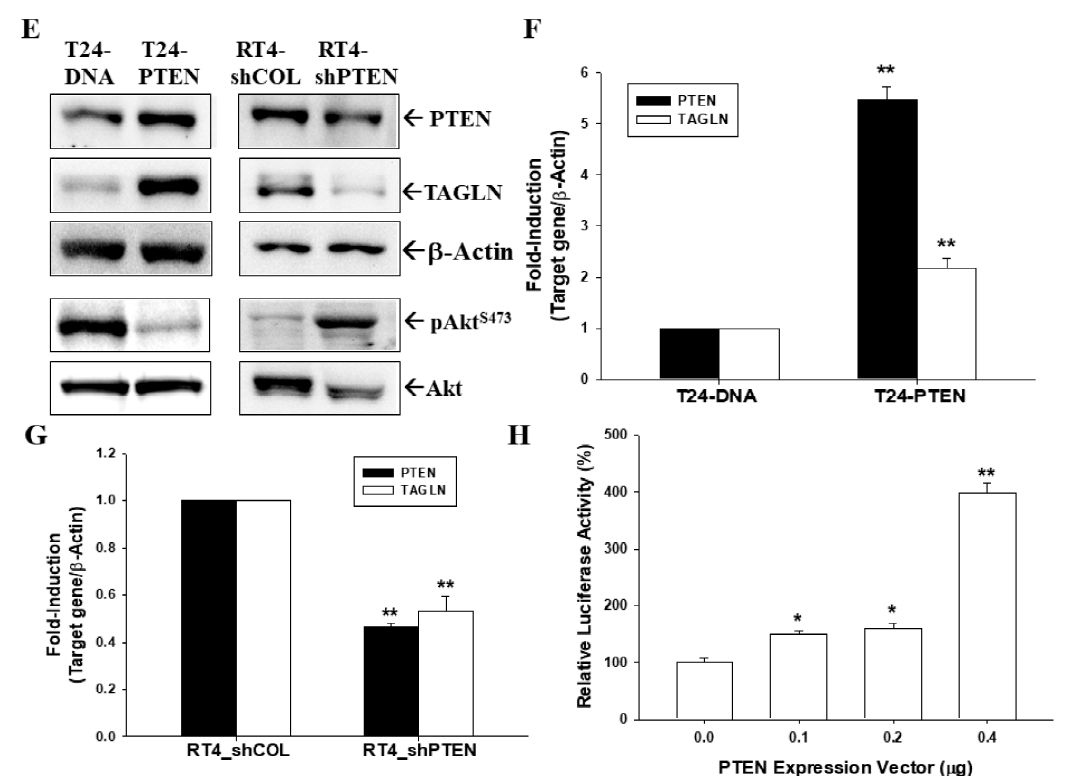
Figure 6. Modulation of p53 and PTEN on TAGLN expression in bladder carcinoma cells. The mock-transfected HT1376 (HT-DNA) and p53-overexpressed HT1376 (HT-p53) cells were lysed, and then TAGLN, p53, and β -actin were determined by immunoblotting ( A ) and RT-qPCR ( B ) assays (± SE; n = 3). The mock-knockdown RT4 (RT4_shCOL) and p53-knockdown RT4 (RT4_shp53) cells were treated with camptothecin (1 μ M) for 16 h. The cells were lysed, and then TAGLN, p53, and β -actin were determined by immunoblotting ( C ). ( D ) The reporter activity of TAGLN reporter vector cotrasnfected with various dosages of p53, as indicated in HT1376 cells. Data are expressed as the mean percentages ± SEs ( n = 6) of luciferase activity relative to the mock-transfected group. The mock-transfected T24 (T24-DNA), PTEN-overexpressed T24 (T24-PTEN), mock-knockdown RT4 (RT4_shCOL), and PTEN-knockdown RT4 (RT4_shpPTEN) cells were lysed, and then TAGLN, PTEN, Akt, pAkt S473 , and β -actin were determined by immunoblotting ( E ). Expressions of PTEN and TAGLN in T24-DNA, T24-PTEN ( F ), RT4_shCOL, and RT4_shPTEN ( G ) cells were determined by RT-qPCR assays ( ± SE; n = 3). ( H ) The reporter activity of TAGLN reporter vector cotrasnfected with various dosages of PTEN, as indicated in HT1376 cells. Data are expressed as the mean percentages ± SEs ( n = 6) of luciferase activity relative to the mock-transfected group. * represented the p < 0.05 and the ** represented the p < 0.01.